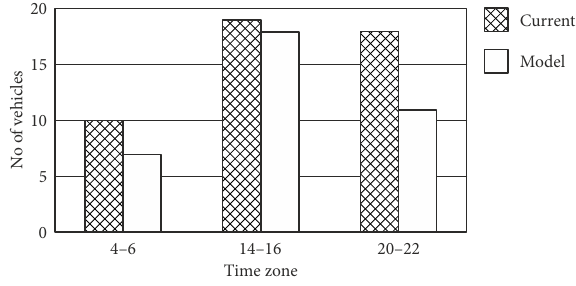
Figure 9. Comparison of current bus traffic and model applied traffic